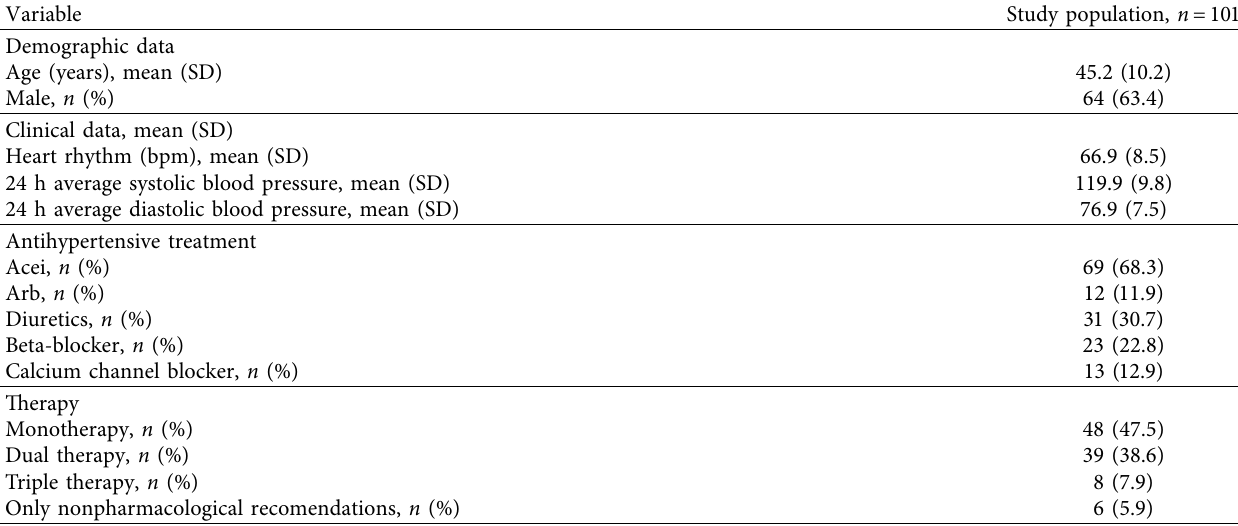
Table 1: Demographic, clinical, and treatment data for the study population.